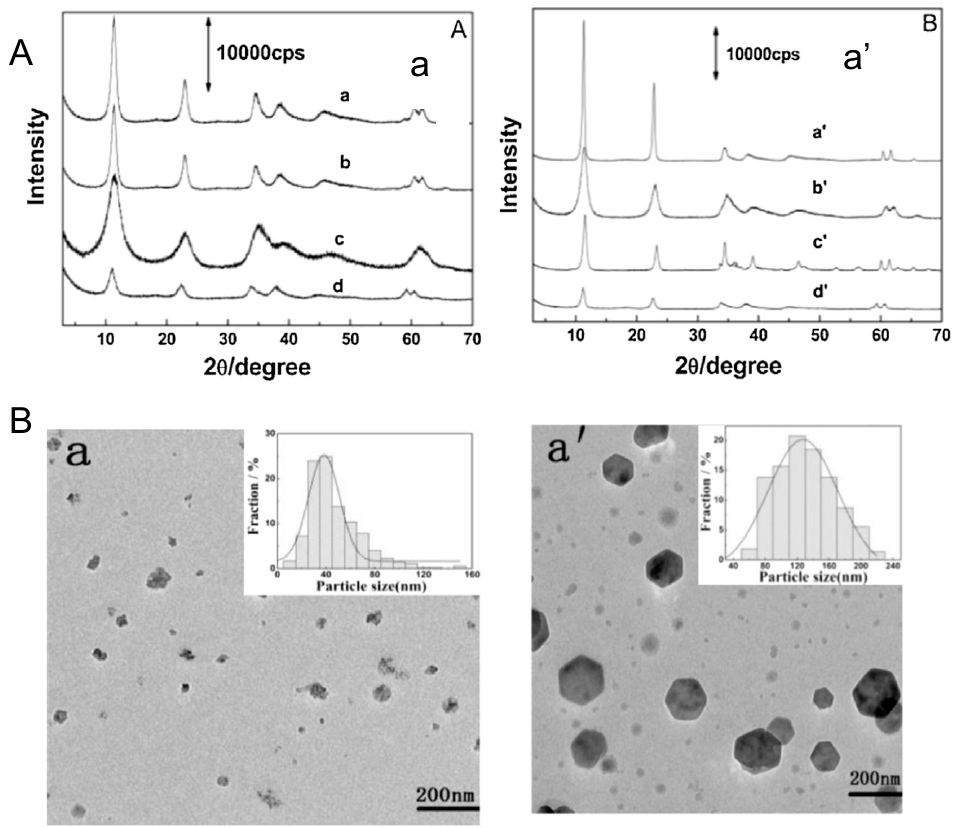
Figure 13. The variation of XRD pattern ( A ) and the TEM images ( B ) without hydrothermal treatment (a) and with hydrothermal treatment (a’). Reproduced with permission from reference [139].